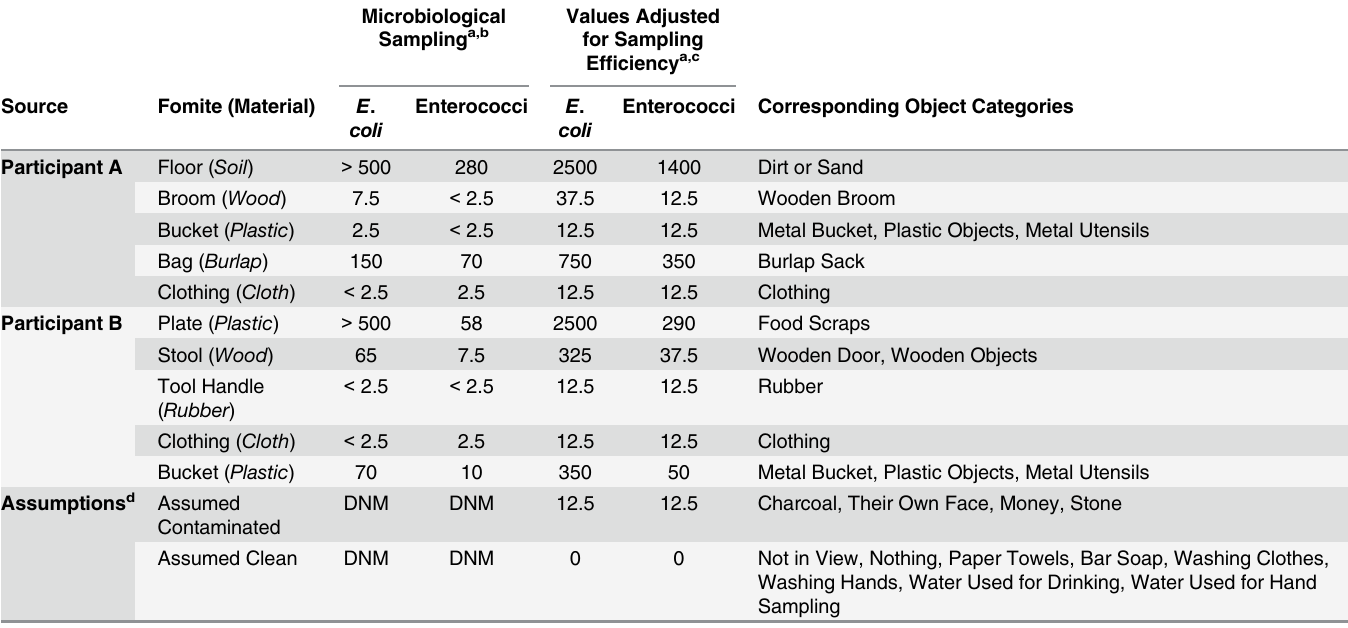
Table 1. Concentrations of Bacteria ( E . coli And Enterococci) on Objects Used in the Exposure